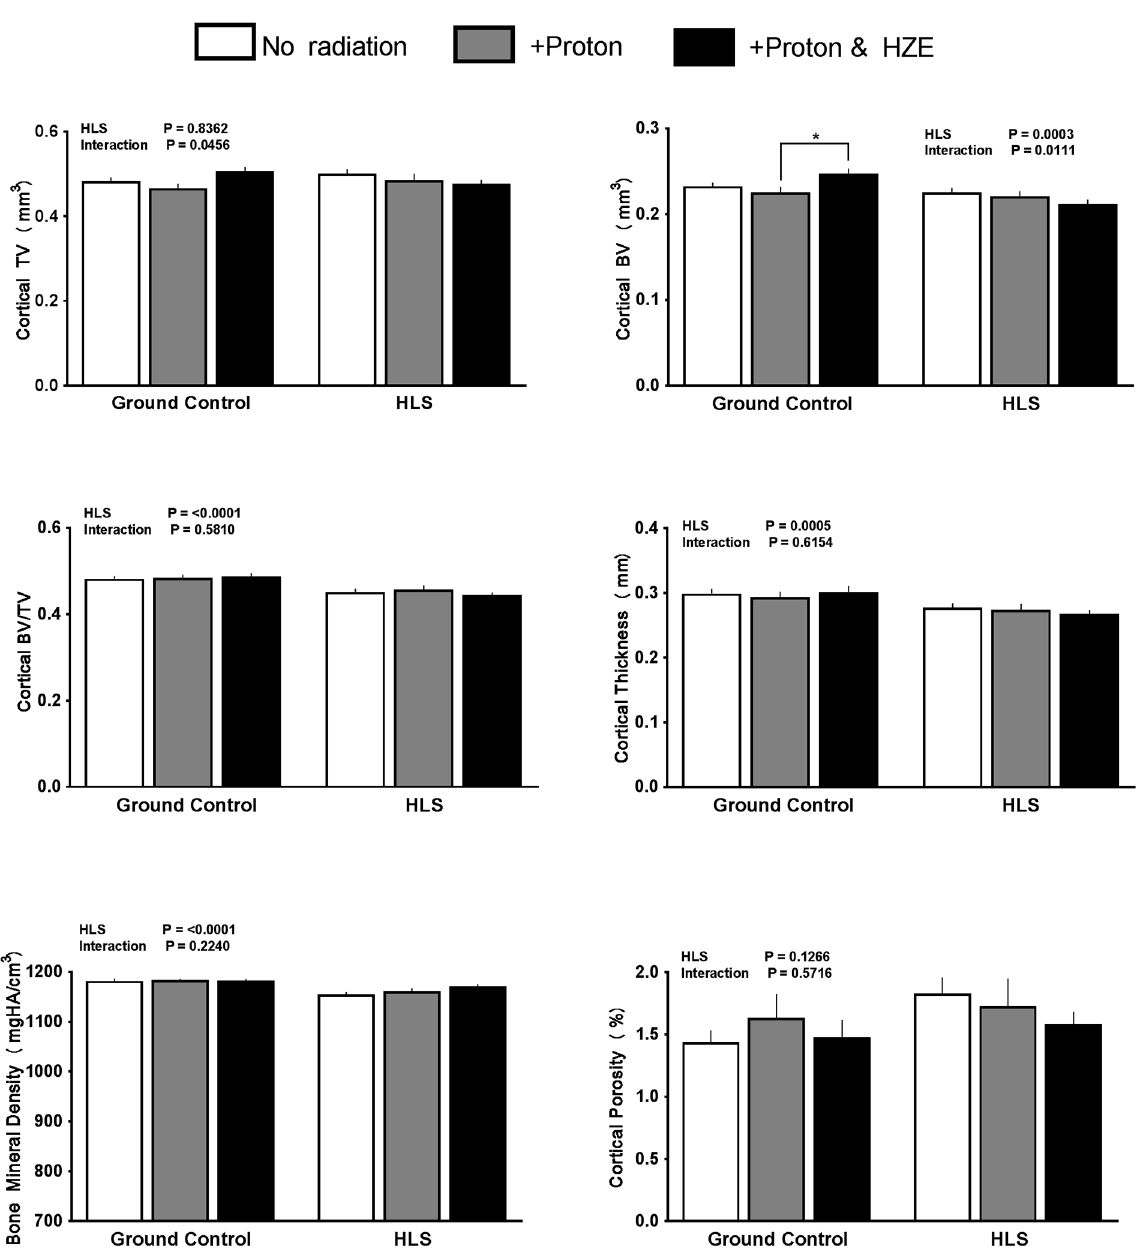
Fig 3. Effect of HLS and radiation on cortical parameters measuredwith MicroCT scans at distal femur. Measures are shown as absolute values at conclusionof study for cortical total volume, cortical bone volume, cortical bone volume fraction (Ct. BVTV), cortical thickness, cortical bonemineral density, and cortical porosity. Valuesare means ± SEM; n = 14–18 bones/group. Values with line and asterisk indications are significantly different (p <